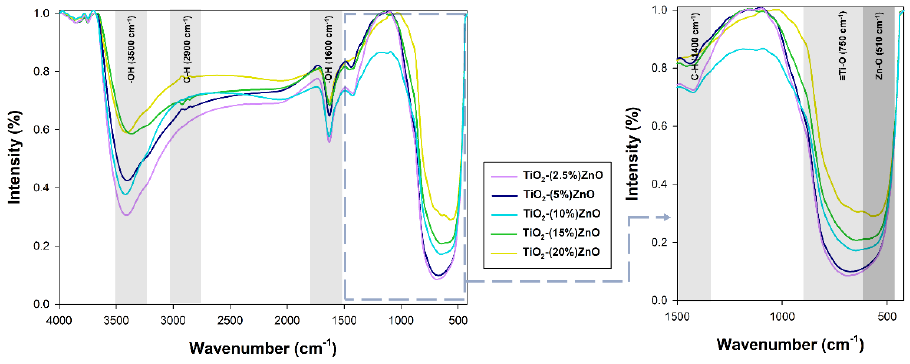
Figure 10. The FTIR spectra for TiO 2 -ZnO systems.